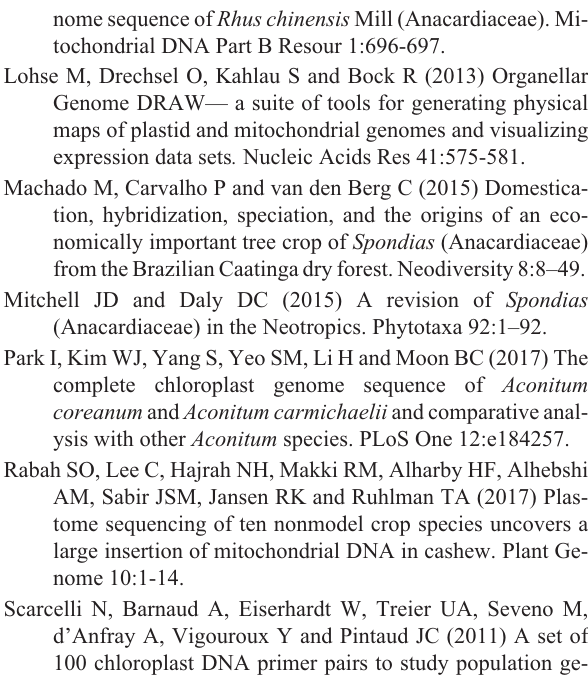
Figure S1 - Chloroplast genome map of S. tuberosa . Figure S2 - Chloroplast genome map of S. bahiensis . Figure S3 - Chloroplast genome map of S. mombin